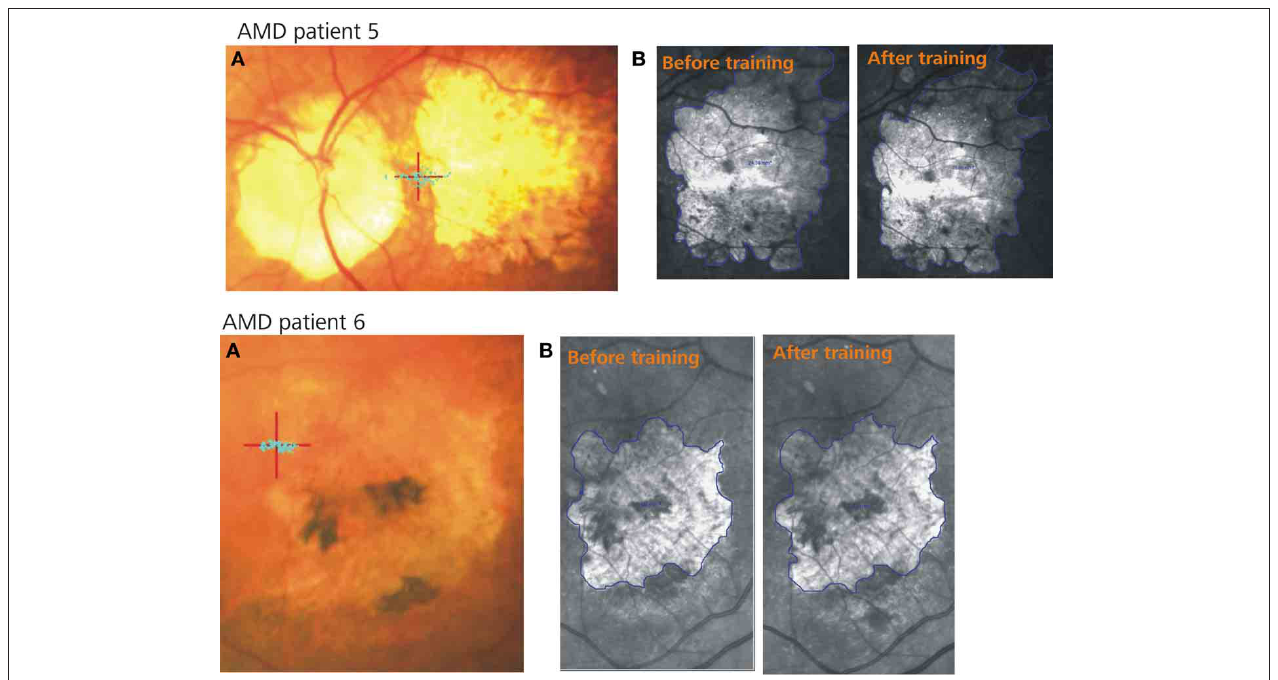
FIGURE 1 | Two example patients. (A) Shows the PRL (red cross) and the fixation stability (blue dots) after training, (B) represents the infrared images of the retina including the scotoma (blue lines) before (left) and after (right) training.